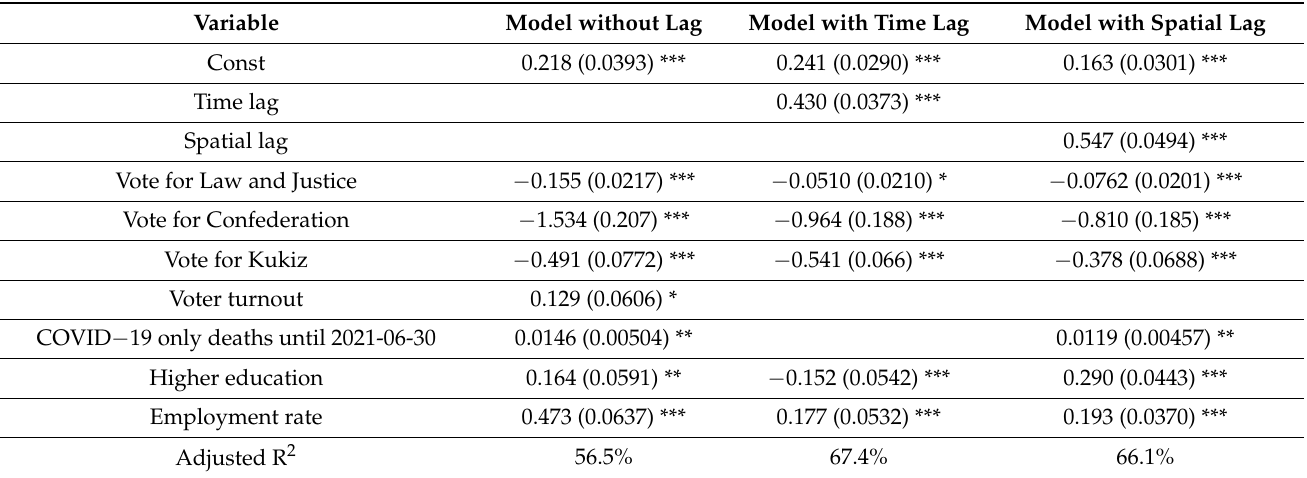
Table 1. Percentage of remaining population in age group 20–39 that were vaccinated against COVID-19 between 30 June 2021 and 31 January 2022.